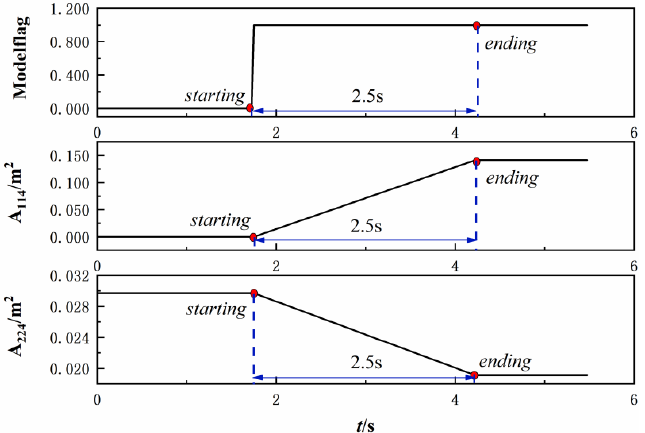
Figure 9. Schedule of control variables with fixed values switching from single bypass to double bypass mode. bypass